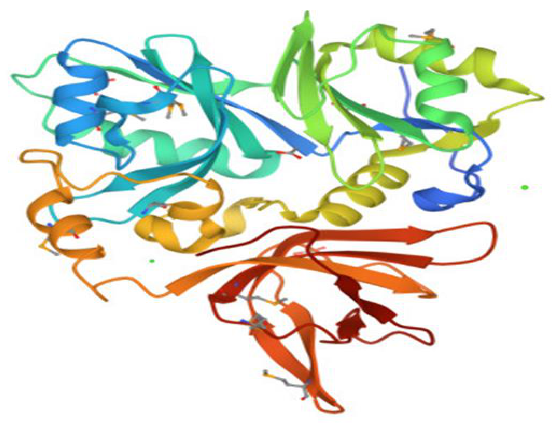
Figure 6. The crystal structure of E. coli (PDB ID: